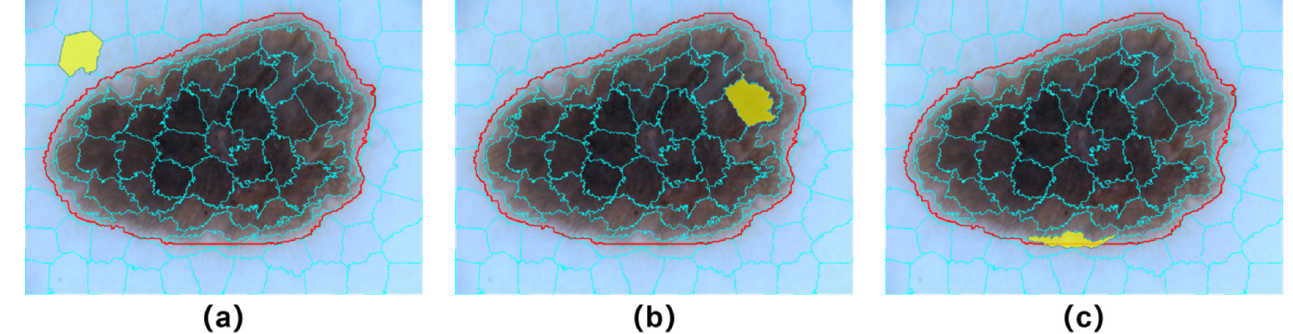
Figure 3. Illustration of relations between the boundary and a superpixel block. ( a ) superpixel is outside of the boundary; ( b ) superpixel is inside of the boundary; ( c ) superpixel intersects with the boundary.